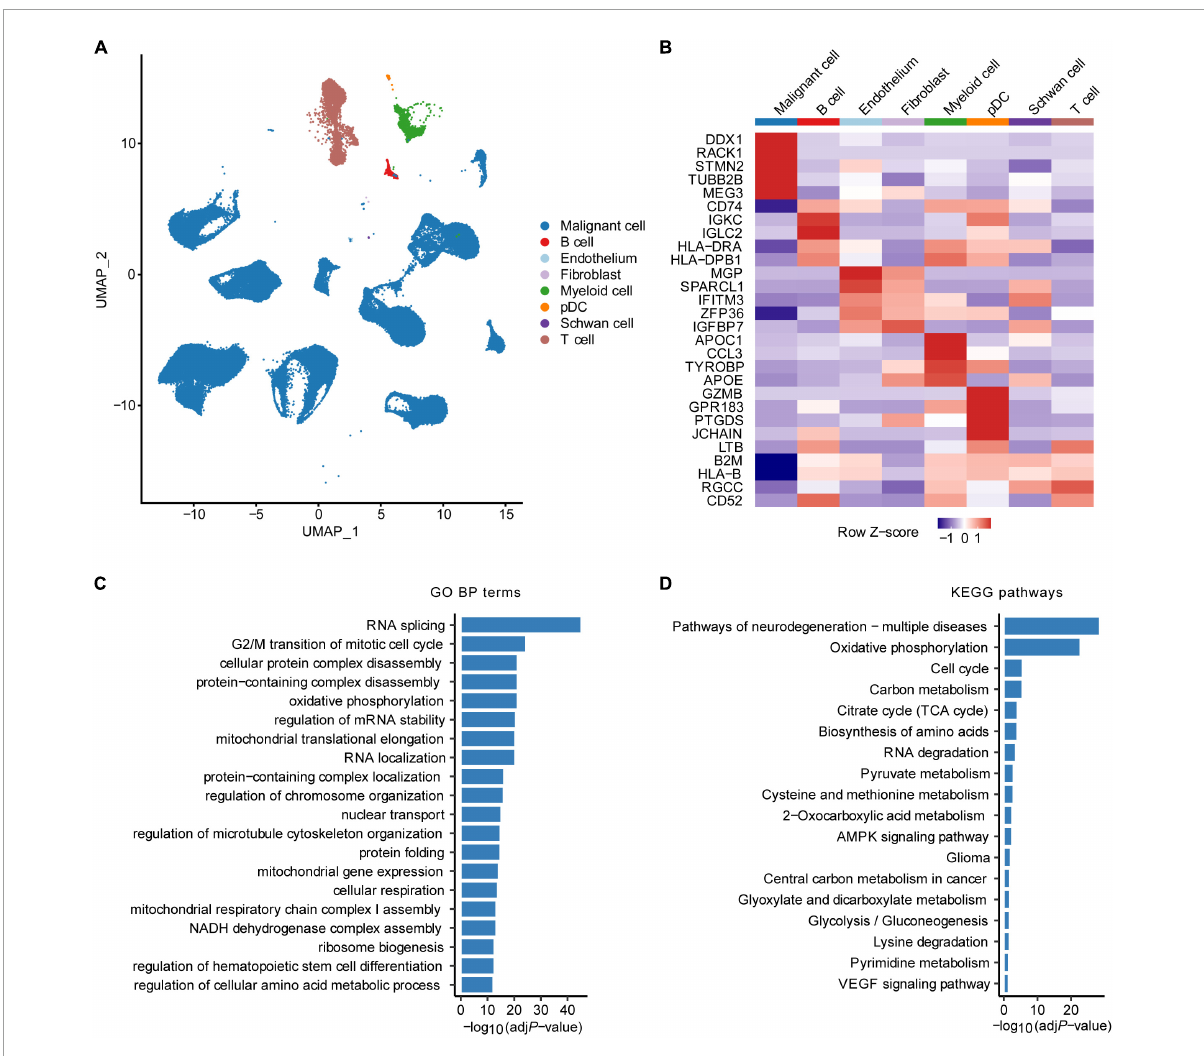
FIGURE1 Identification of malignant cell marker genes by scRNA-seq analysis. (A) UMAP plot colored by various cell types. (B) Heatmap showing the top five marker genes of each cell type. GO biological process (BP) terms (C) and KEGG pathways (D) enrichment analysis of malignant cell marker genes of HRNB. pDC, plasmacytoid dendritic